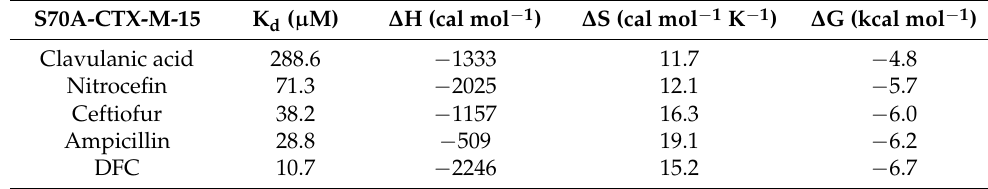
Table 3. Thermodynamic parameters determined by isothermal titration calorimetry.